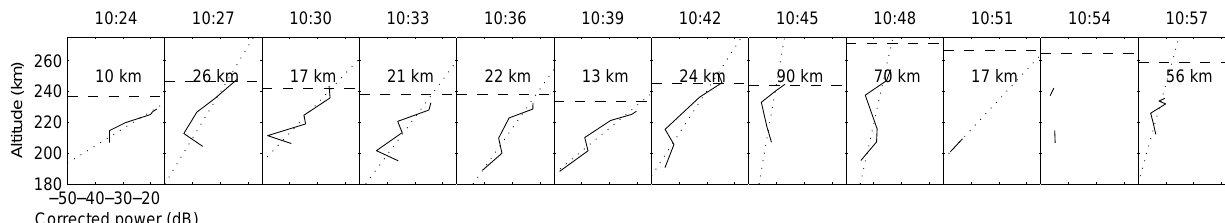
Fig. 6. Height profiles (solid lines) of backscatter power for all pump cycles during the period 5 November 2002 at 10:24–11:00 UT. The horizontal dashed lines indicate the upper-hybrid resonance heights. The diagonal dotted lines indicate linear fits to the profiles and the distances indicated in each panel are the e -folding lengths of the electron density perturbations derived from these fits.